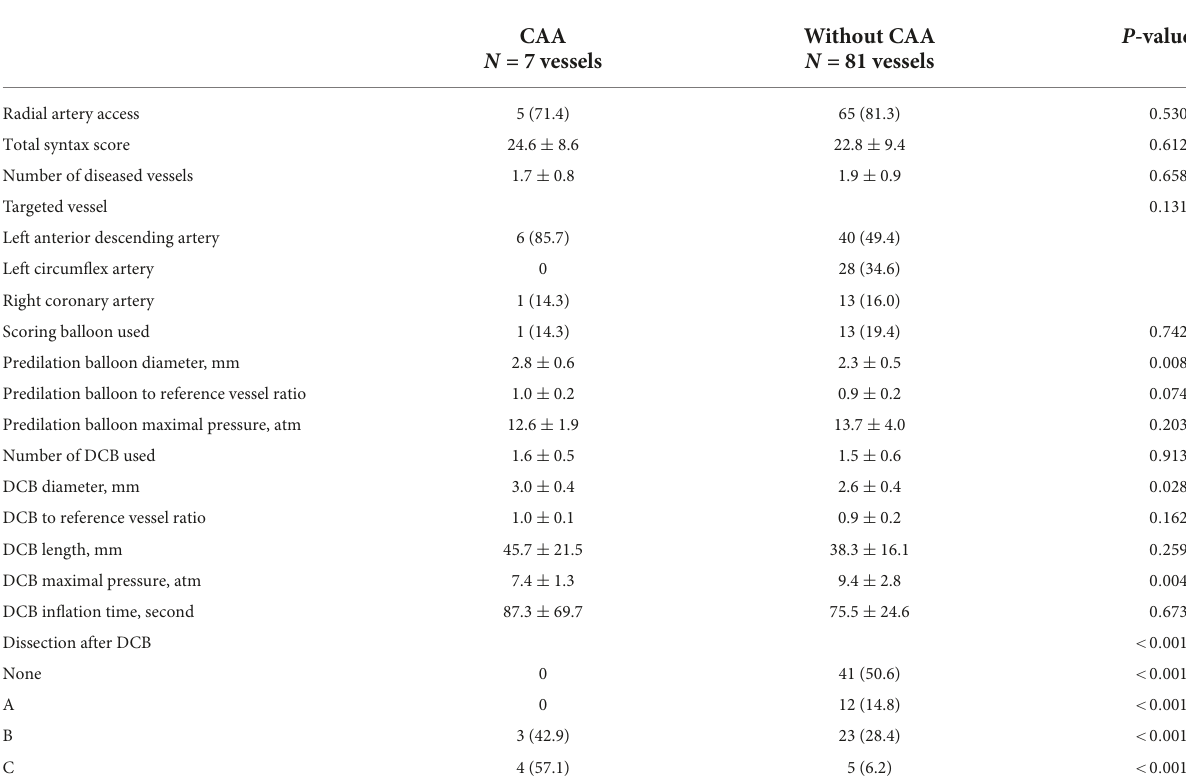
TABLE 2 Angiographic and procedural characteristics according to the presence of aneurysm after DCB-only